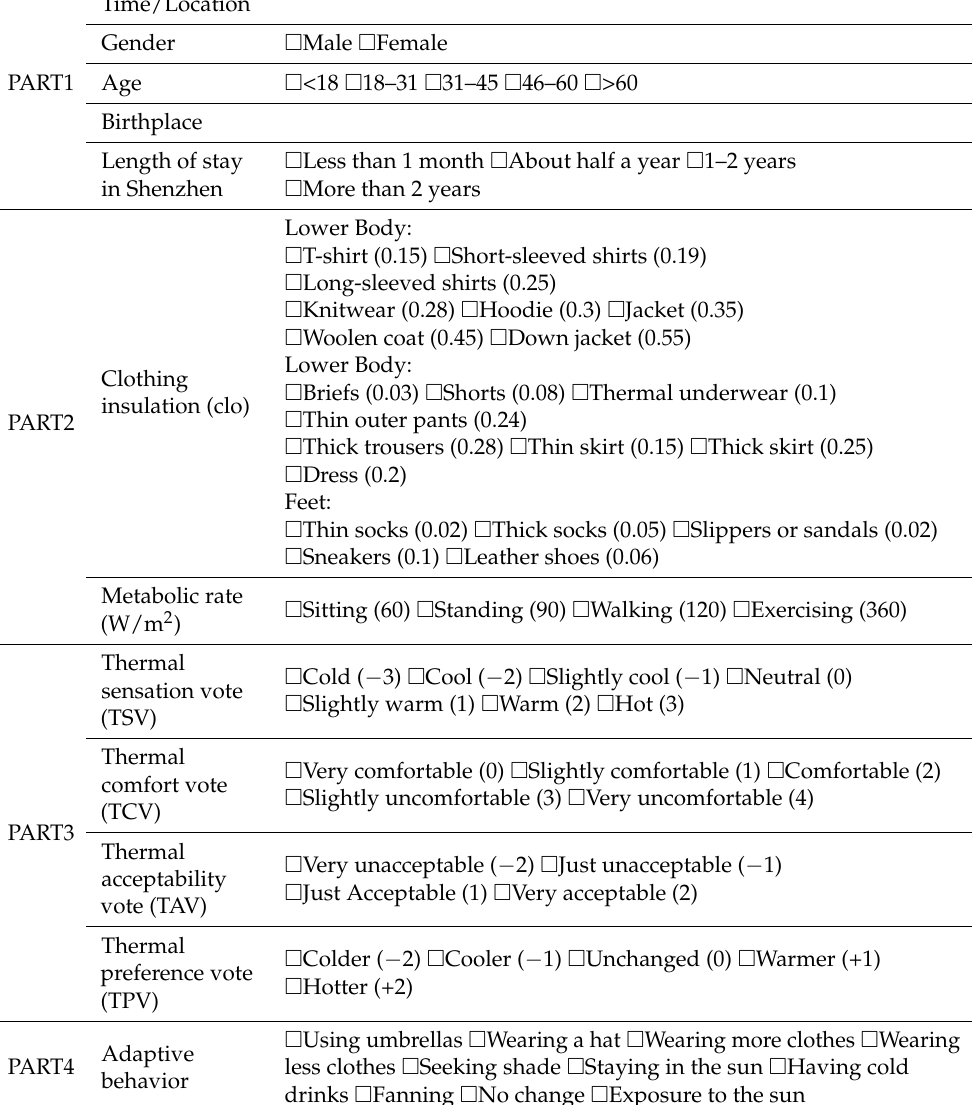
Table 4. The questionnaire used in this